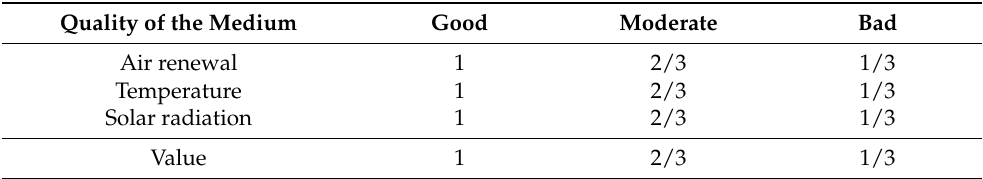
Table 3. Quality of the medium. Assignment of values. Good stands for good quality of virus transmission and it means no air renewal, low temperature, and no solar